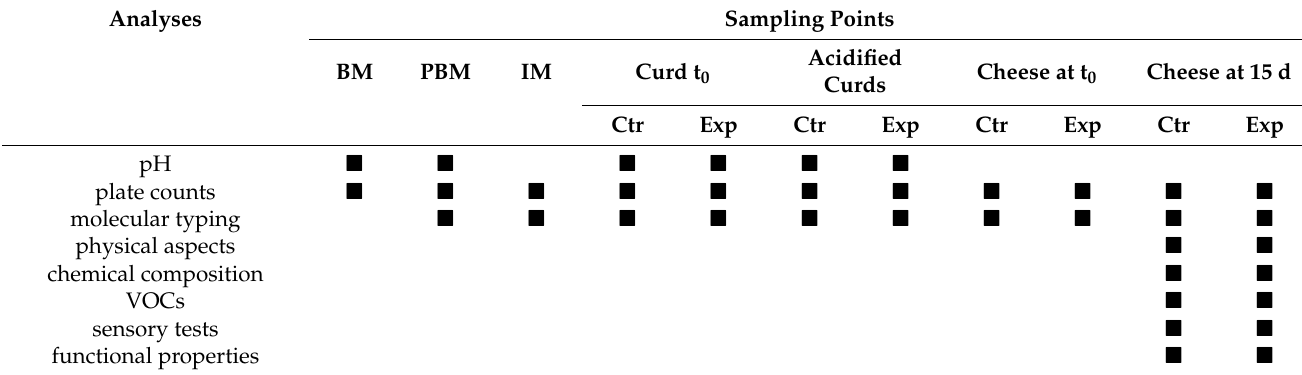
Table 1. Sampling points a and analyses performed during cheese